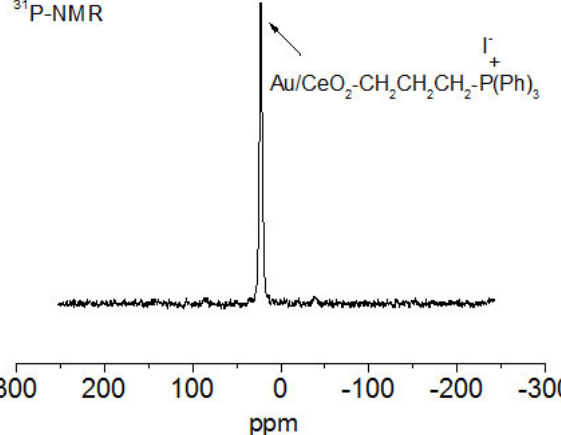
Figure 3. Solid ‐ state 31 P ‐ NMR spectrum of TPP–AuCeO 2 confirming the presence of the TPP group in TPP–AuCeO 2 TPP–AuCeO 2 .